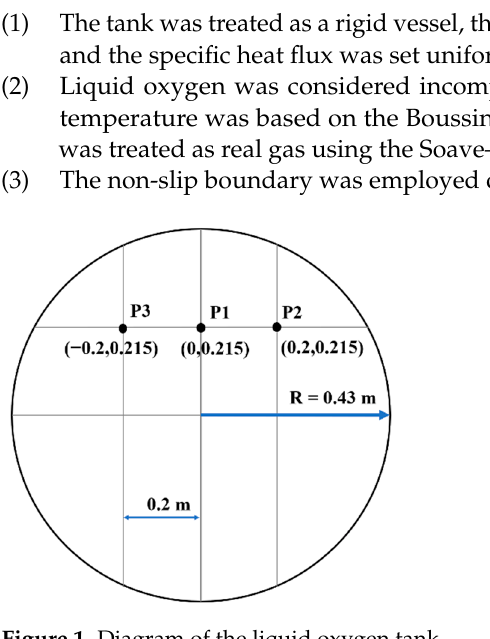
Figure 1. Diagram of the liquid oxygen tank. Table 1. Simulation cases.